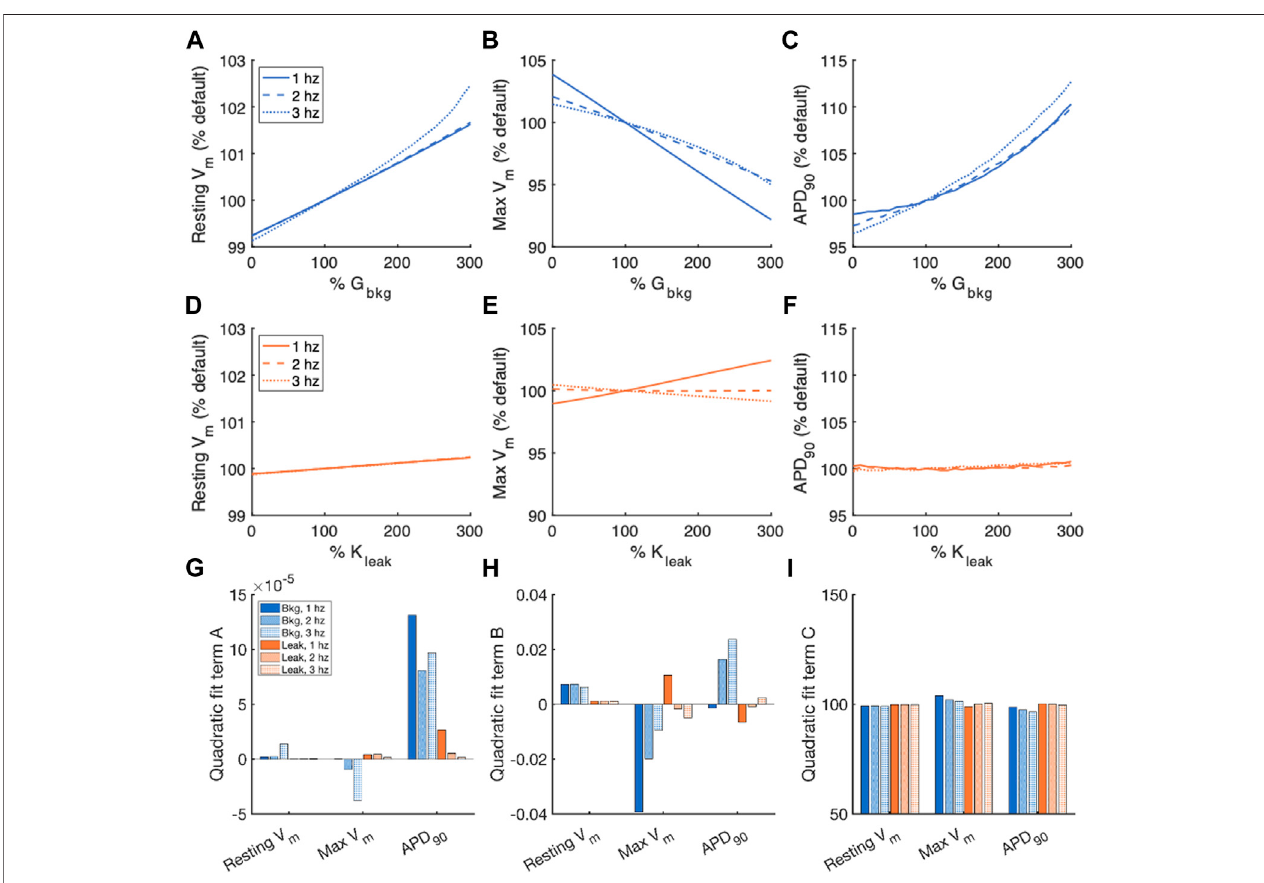
FIGURE 4 | Summary of effects of modulating G bkg or K leak independently on V m . Sensitivity analyses of modulating G bkg on measurements of (A) resting V m , (B) maximum V m , and (C) time to 90% repolarization normalized by the default model parameters. Sensitivity analyses of modulating K leak on measurements of (D) resting V m , (E) maximumV m ,and (F) timeto90%repolarizationnormalizedbythedefaultmodelparameters.Summaryofthe (G) quadraticterm, (H) lineartermand (I) constant term calculated by quadratic polynomial fi ts to the normalized sensitivity analyses in (A – H) .